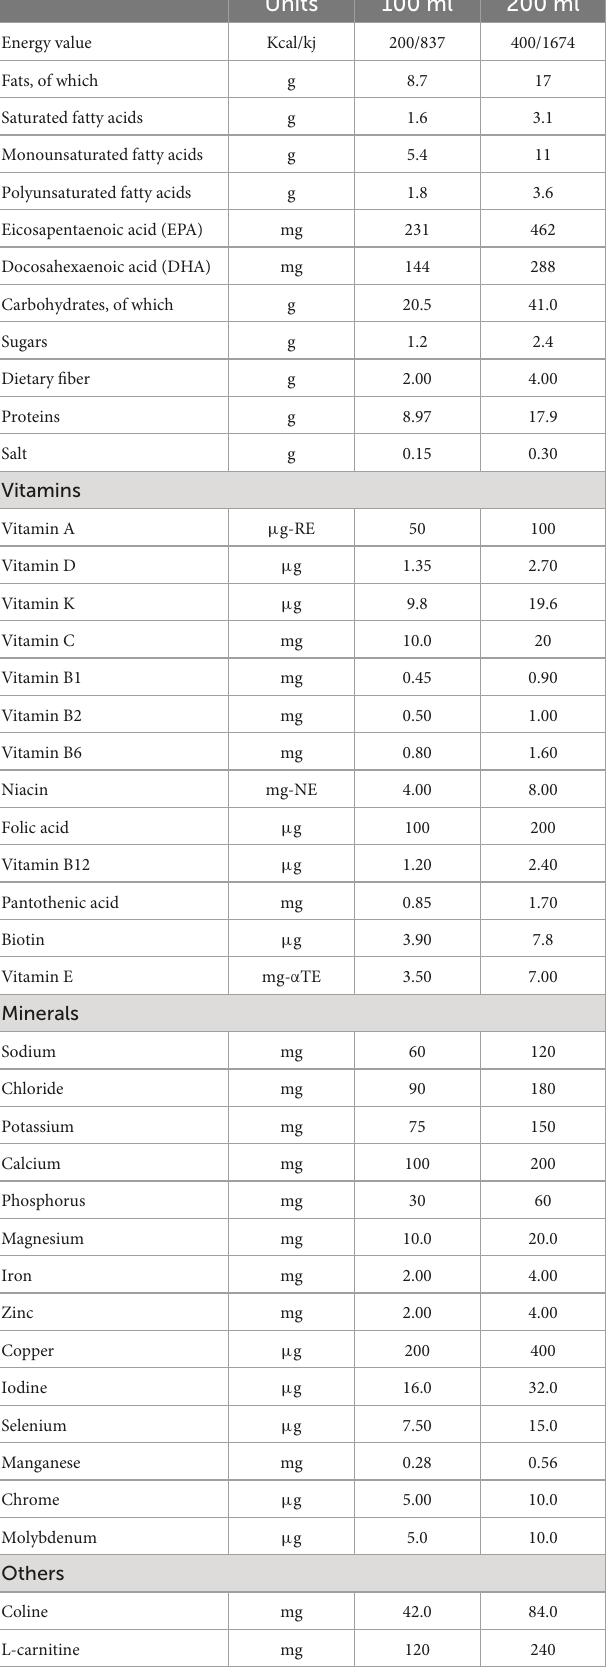
TABLE 1 Nutritional composition of the oral nutritional supplement renacare R (cid:13)